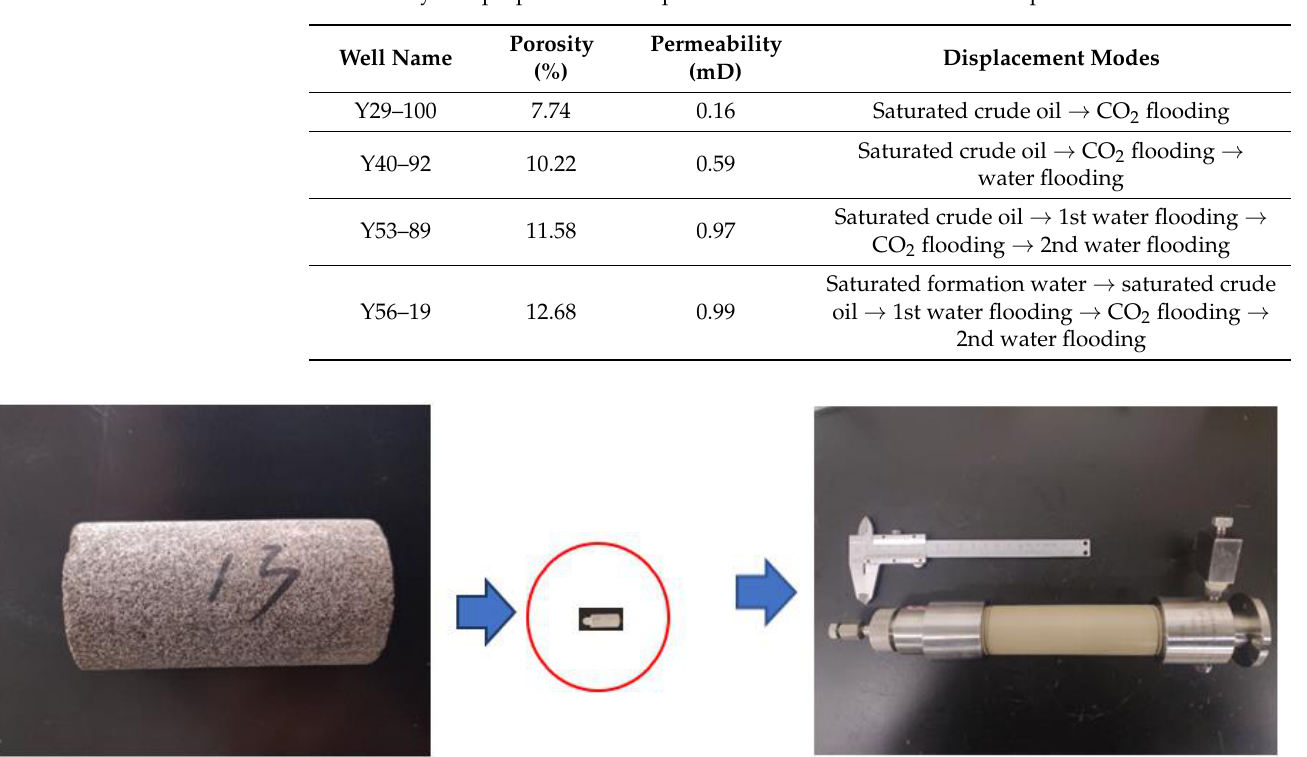
Table 1. Physical properties and displacement mode of the four core samples.